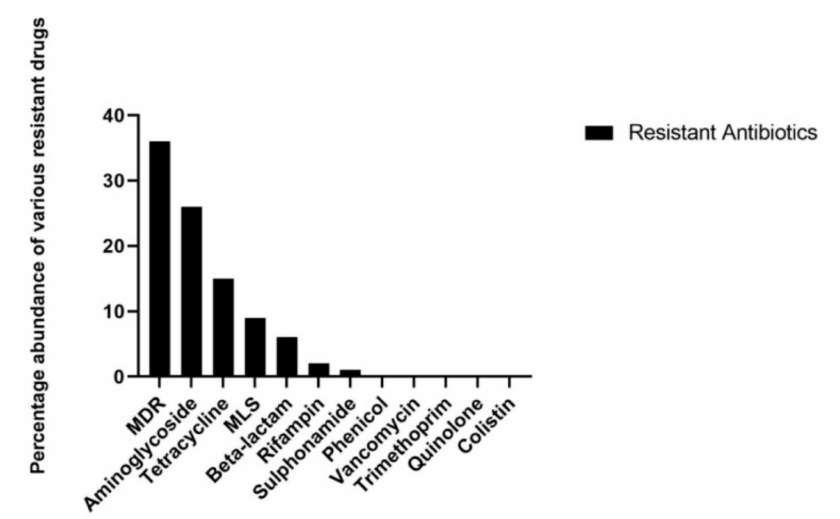
Figure 1. Antimicrobial resistance pattern of poultry fecal microbiota to various drugs. Multidrug resistance and macrolide-lincosamide-streptogramin are abbreviated as MDR and MLS, respectively.